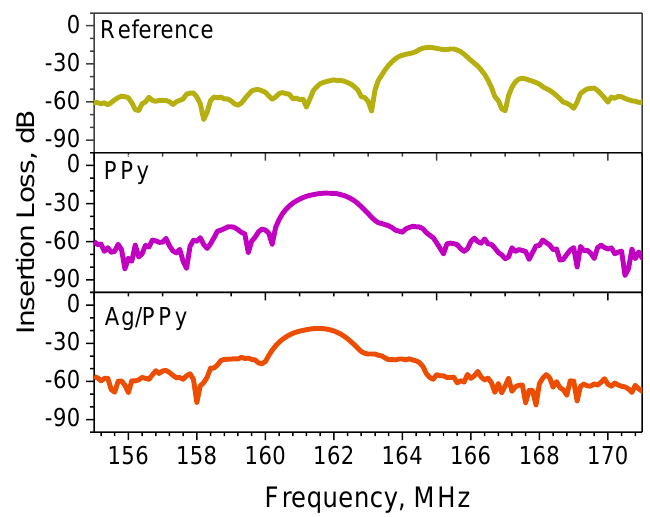
Figure 3. Transmission scattering parameters (S 21 ) of the uncoated (reference) and coated (with PPy or Ag/PPy sensitive layer) L-SAW structures.